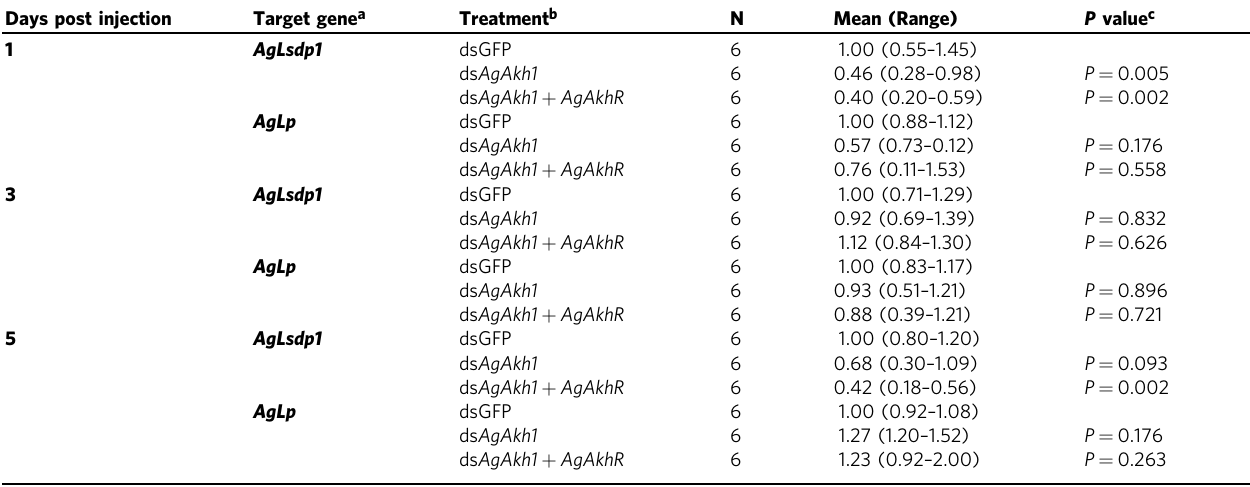
Table 1 Effect of ds AgAkh1 and ds AgAkh1 + ds AgAkhR treatment on AKH signaling pathway downstream gene